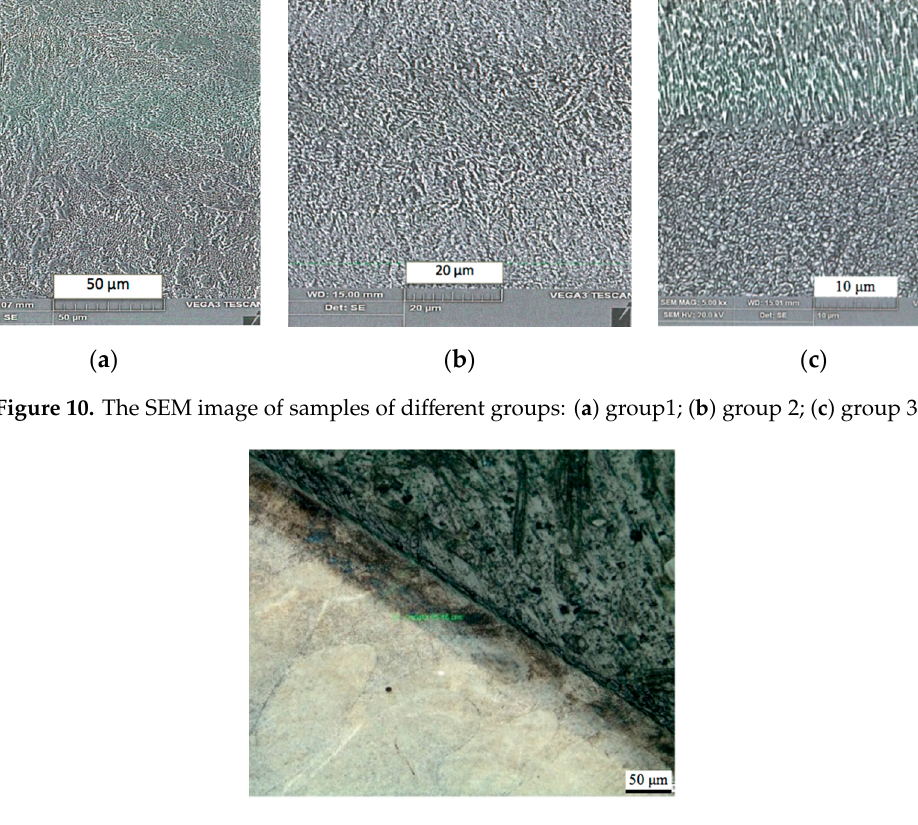
Figure 11. Photomicrograph of the sample of group 3.